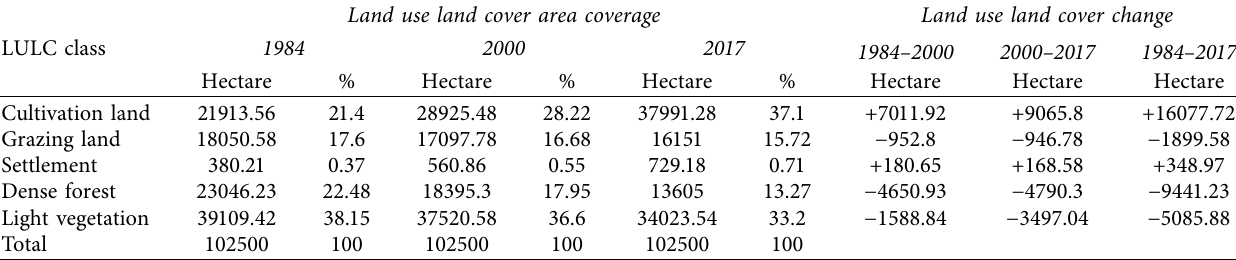
Table 2: Land use land covers change (1984–2017) and their rate of change.